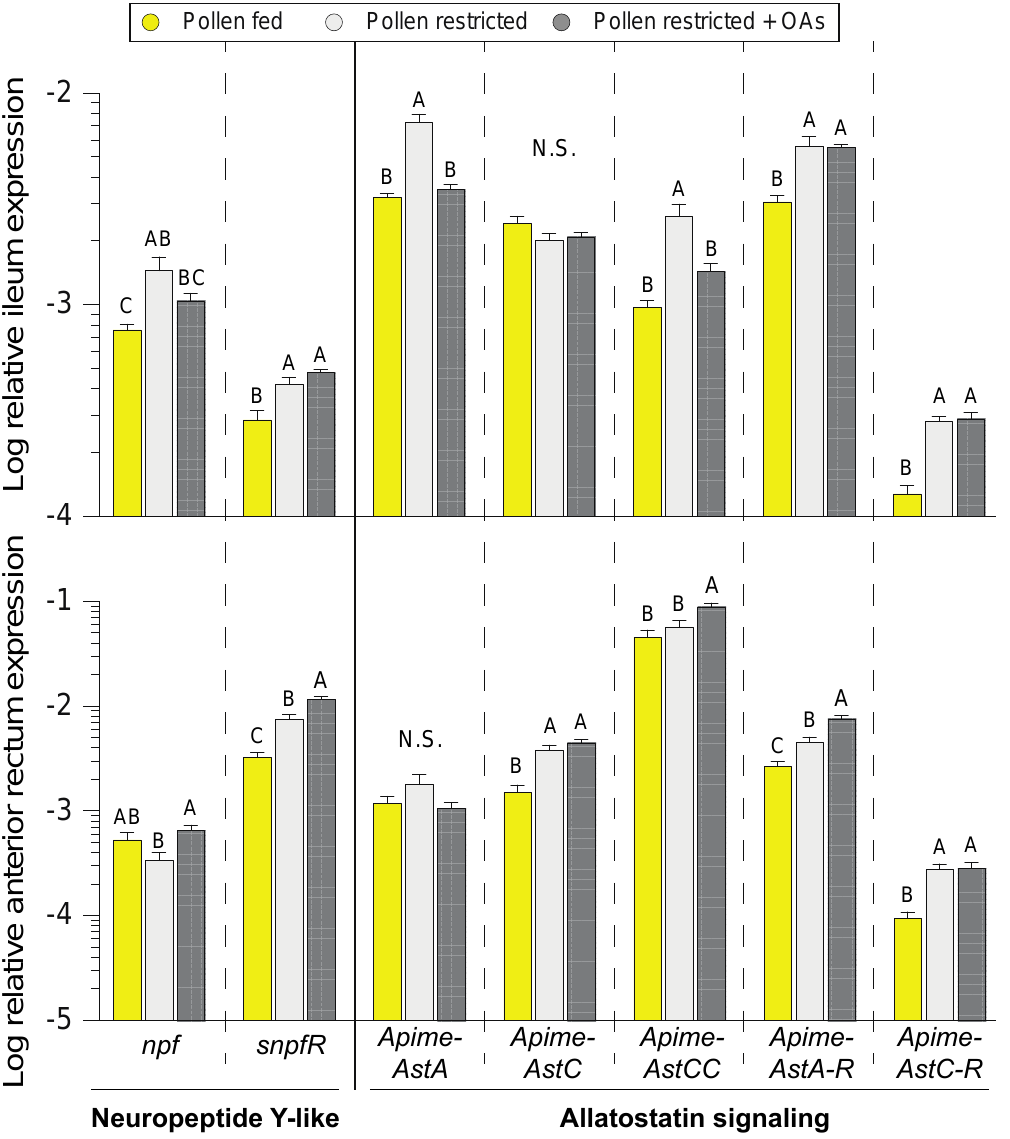
Figure 5. Expression of enteroendocrine signaling gene transcripts in hindgut tissues of honey bees subjected to different diet treatments ( n = 16–19 cages). Error bars represent standard error (SE). Different letters indicate Tukey HSD P < 0.05.